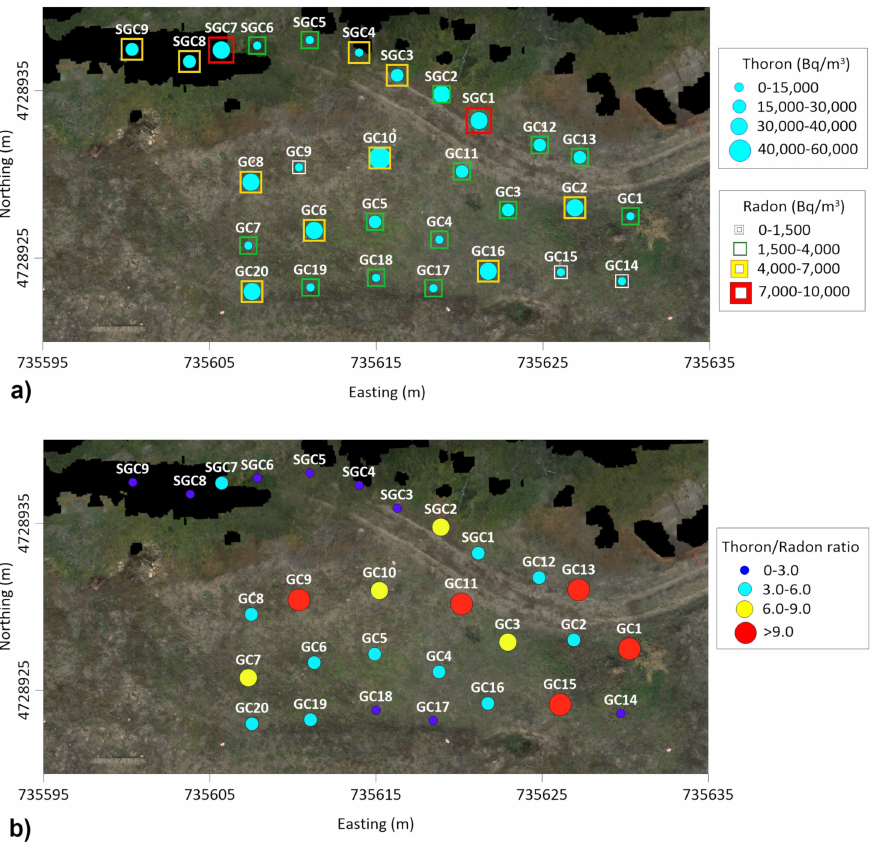
Figure 7. Rn and Th maps. Geochemical maps for the measured ( a ) Th and Rn concentrations: Red and yellow squares show areas of very high and high Rn concentrations, while green and white ones represent low and very low concentrations. Th concentrations are classified into four classes represented by different light-blue circle dimensions; ( b ) Th/Rn ratios: Red and yellow circles indicate areas of very high and high ratios while light-blue and blue circles represent low and very low ratio